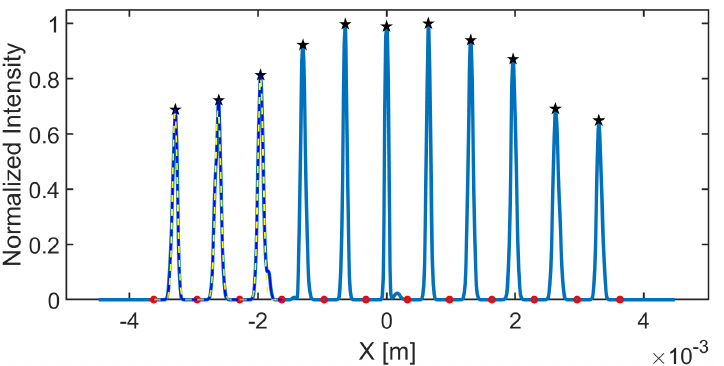
Figure 4. Extraction of the RMS spot size of each beamlet with a single Gaussian fit. The red circles and black polygons are the borders and the peak of each beamlet, respectively. This fit begins with the left beamlet and continues until all beamlets are fitted. The light yellow dashed line represents the result of each single Gaussian